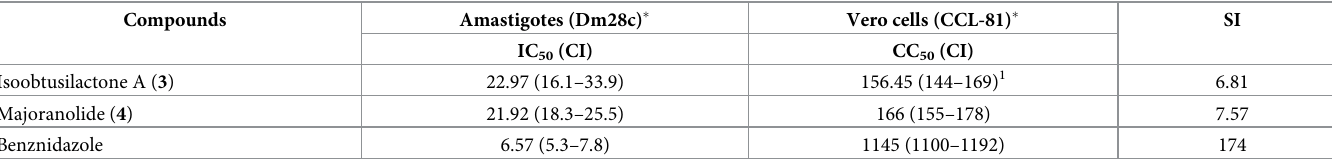
Table 1. Activity of butanolides and benznidazole against amastigotes of T . cruzi in 24 hours of treatment. Compounds